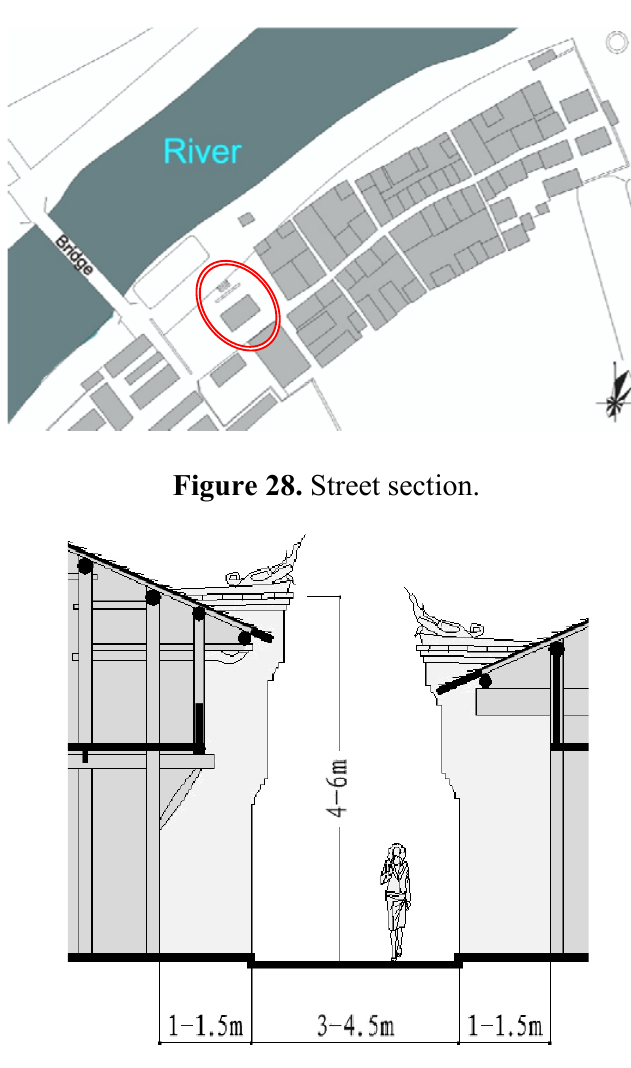
Figure 27. Zhai J.W. village plan.